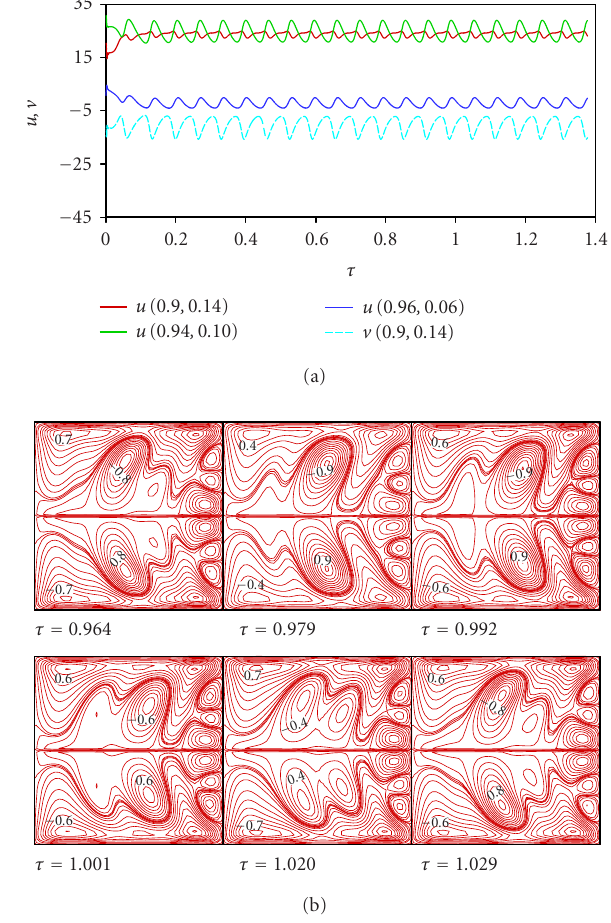
Figure 7: (a) Dynamic responses of solution b at L 2 = − 12 . 1 la- beled in Figure 2b to finite random disturbances: periodic oscilla- tion and (b) typical secondary-flow patterns in one period (period = 0 . 065, σ = 0 . 02, Pr = 0 . 7, Dk = 300, and L 1 = 28).